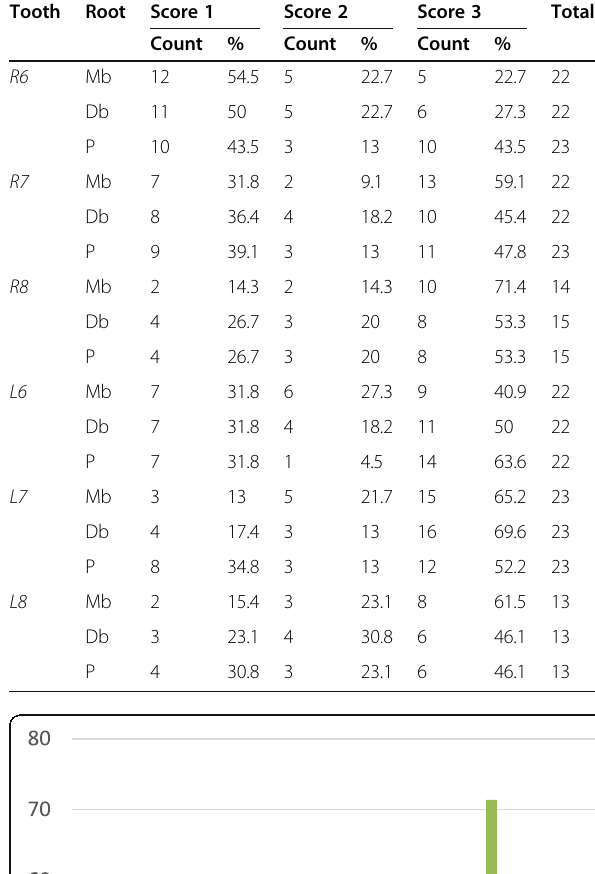
Table 4 Frequency and percentage of occurrence of each root in each of the three scores (R = right, L = left, 6 = first molar, 7 = second molar, 8 = third molar, mb = mesiobuccal root, db = distobuccal root, p = palatal root)